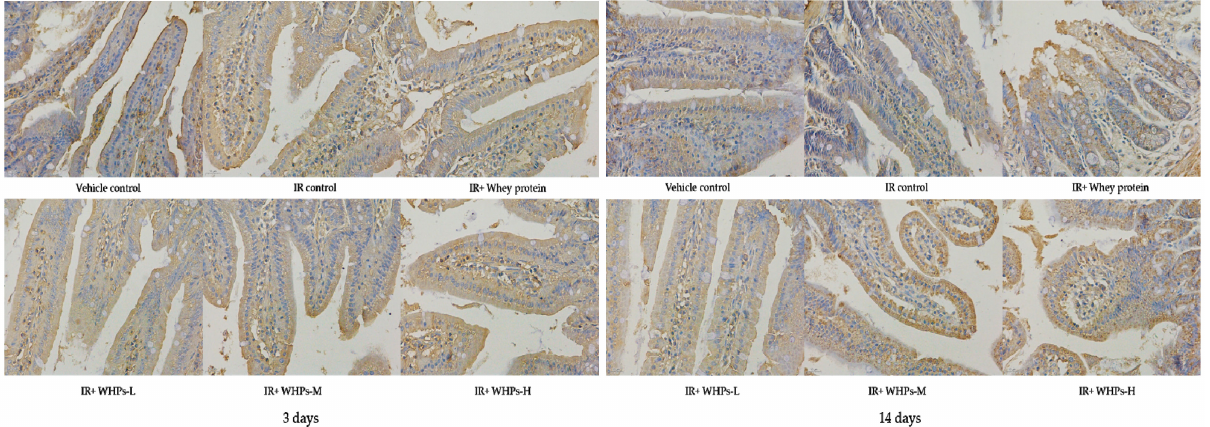
Figure 8. Effect of WHPs on the expression of ZO-1 proteins in mice (400 × ). IR, irradiated mice; IR+WHPs-L, irradiated mice+low-dose whey hydrolysate peptides; IR+WHPs-M, irradiated mice+medium-dose whey hydrolysate peptides; IR+WHPs-H, irradiated mice+high-dose whey hydrolysate peptides.